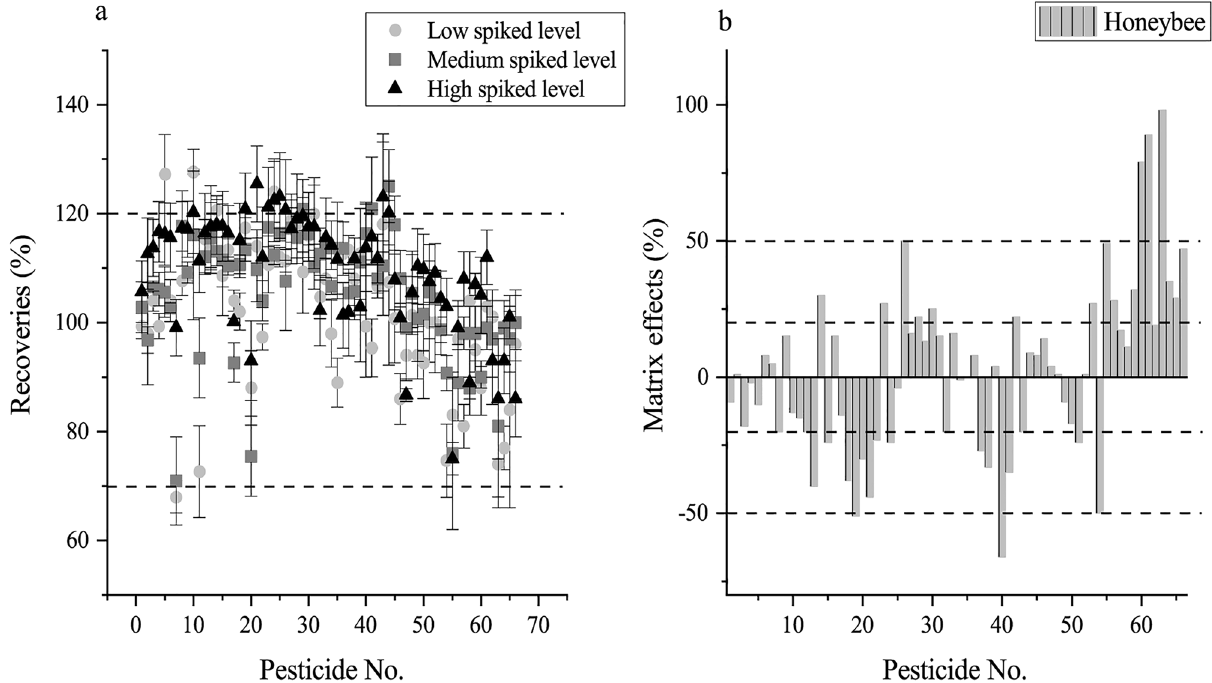
Figure 2. Validation of the method used to investigate 66 pesticides in honeybees. ( a ) Recoveries of 66 pesticides at three different concentration levels for honeybees (n = 5) at low, medium and high levels. ( b ) Matrix effects (%) of the 66 pesticides investigated in the honeybees are